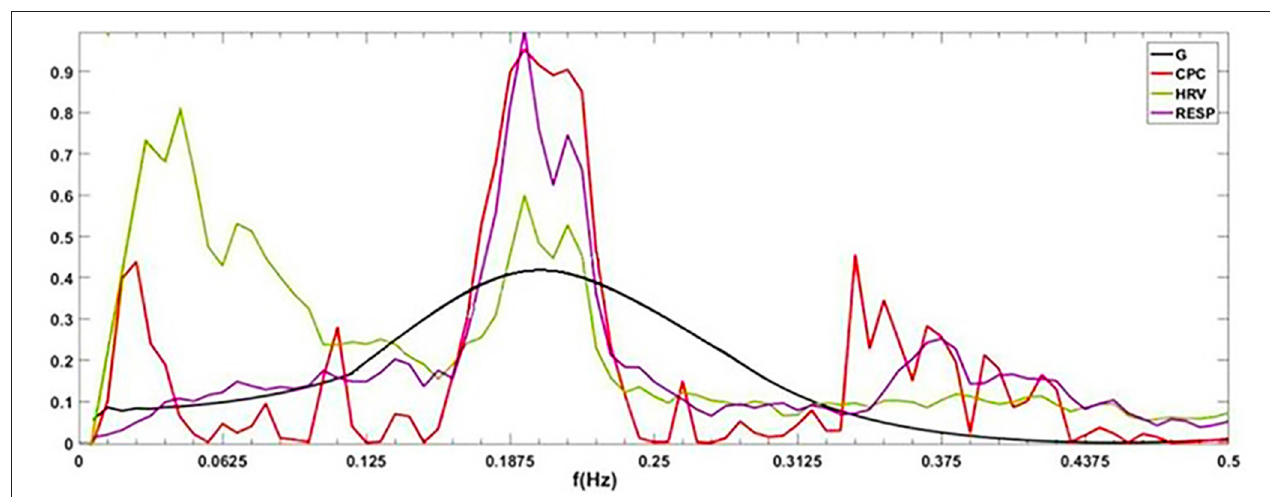
FIGURE 6 | G(f) (CRF), CPC, power spectral density of HRV and respiration. By definition, cardiopulmonary resonance function CRF, reflects the strength of RSA, with the peak near the mean of the respiration rate, while CPC is the correlation between HRV and respiration with respect to their power spectrum, having multiple peaks. As the name indicated, CRF well capture the resonance nature of cardiopulmonary system.